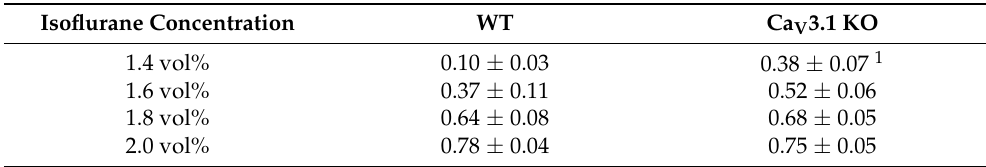
Table 1. Suppression to burst ratio (BSR) in WT and Ca V 3.1 KO animals under isoflurane (mean ±